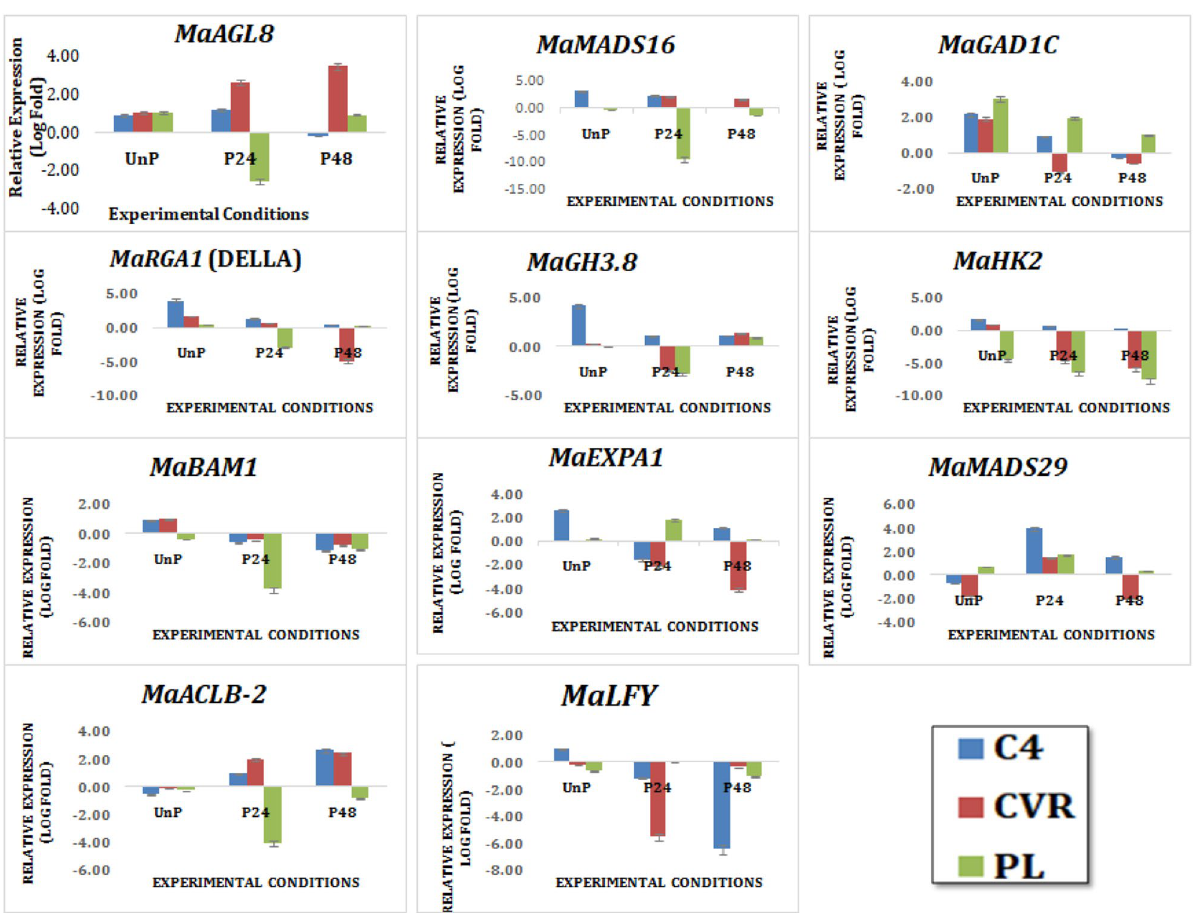
Figure 3. Relative expression of genes in ovary of three banana cultivars (C4, CVR and PL) at three conditions namely Un pollinated (UnP), 24 h after pollination (P24) and 48 h after pollination (P48). Relative expressions of genes with respect to experimental condition (X-axis) were expressed in Log fold change (Y axis). The mean differences between relative gene expressions were analyzed by ANOVA, p < 0.05. p values of the two-way ANOVA are shown in (Supplementary Material 2).